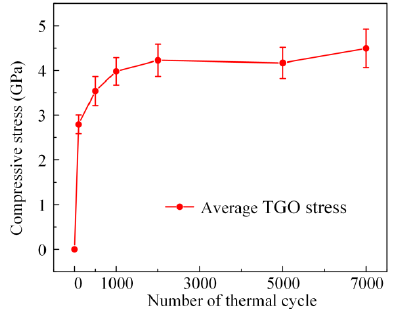
Figure 10. TGO stress fields of all specimens.